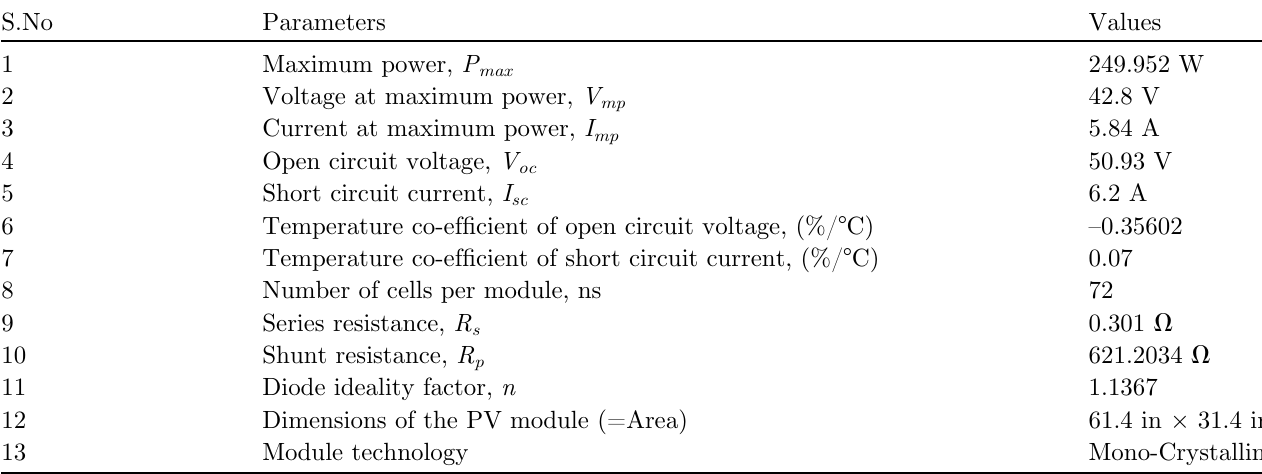
Table 1. Parameters of SPR-X20-250-BLK PV Module at STC (1000 W/m 2 and 25 °